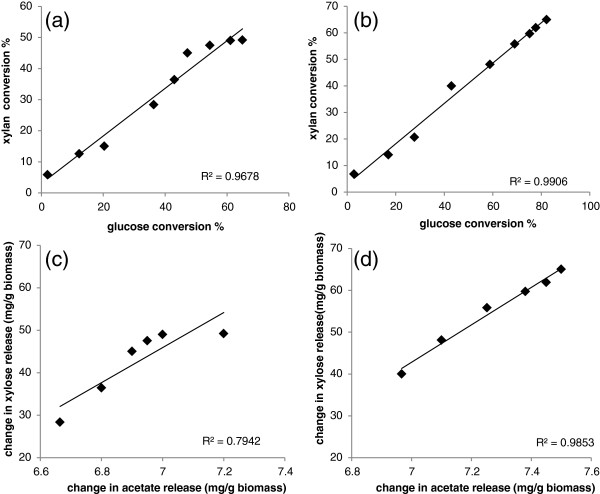
Change in glucan conversion plotted against change in xylan conversion for Accellerase XC (a) and optimized Accellerase XC (b) over 120 h of incubation with pretreated barley straw (2% biomass load). Xylose released plotted against acetate released by Accellerase XC (c) and optimized Accellerase XC (d), from pretreated barley straw (2% biomass load) over 120 h of incubation. Optimized Accellerase XC composition was identical to those used in Figure 
3c. Enzymes were included at 15 mg/g glucan. Error bars represent SD of the mean (n = 8).